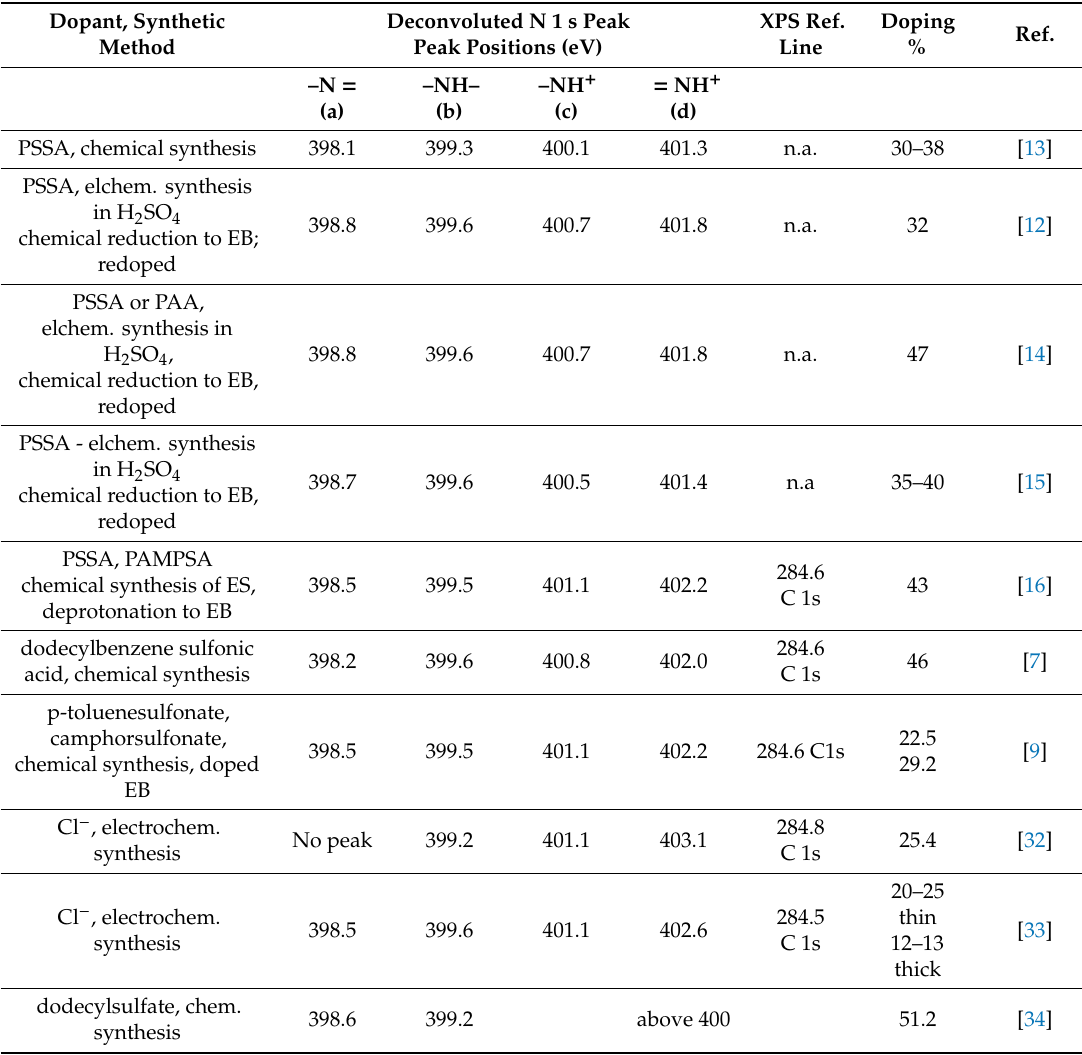
Table 4. Data for the deconvolution of the N spectra and the extent of doping of PANIs synthesized in the presence of di ff erent doping